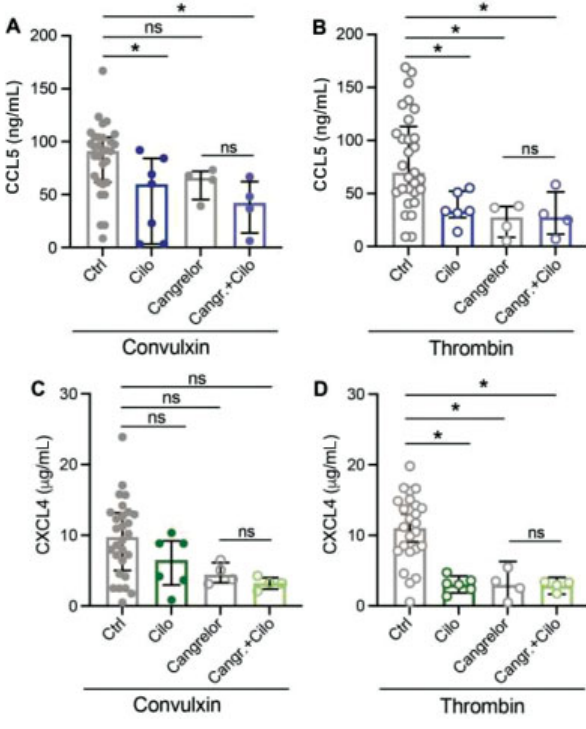
Fig. 6 Combination treatment with cangrelor þ cilostazol has no additional effects on chemokine release. Washed platelets (2 (cid:1) 10 8 / mL) from healthy volunteers were pretreated with P2Y 12 inhibitor cangrelor, 5minutes before activation and CCL5 ( A, B ) and CXCL4 ( C, D ) release was determined as described. Platelets were incubated 10minutes prior to activation with the PDE3 inhibitor cilostazol. Closed circles represent convulxin activation and open circles represent thrombin activation. CTRL: n ¼ 25 – 30; Cilo: n ¼ 6 – 7; Cangrelor: n ¼ 4; and Cangr. þ Cilo: n ¼ 4. Median with interquartile range. (cid:4) p < 0.05 and (cid:4)(cid:4) p < 0.01, analysis of variance with Sidak